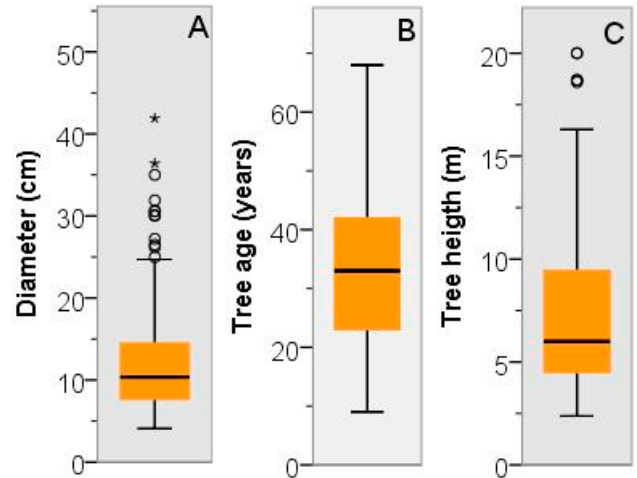
Figure 5. The estimated distribution of trunk diameter ( A ), tree age ( B ), and maximum height ( C ), of the 256 L. azorica (Seub.) Franco samples measured in São Miguel Island.